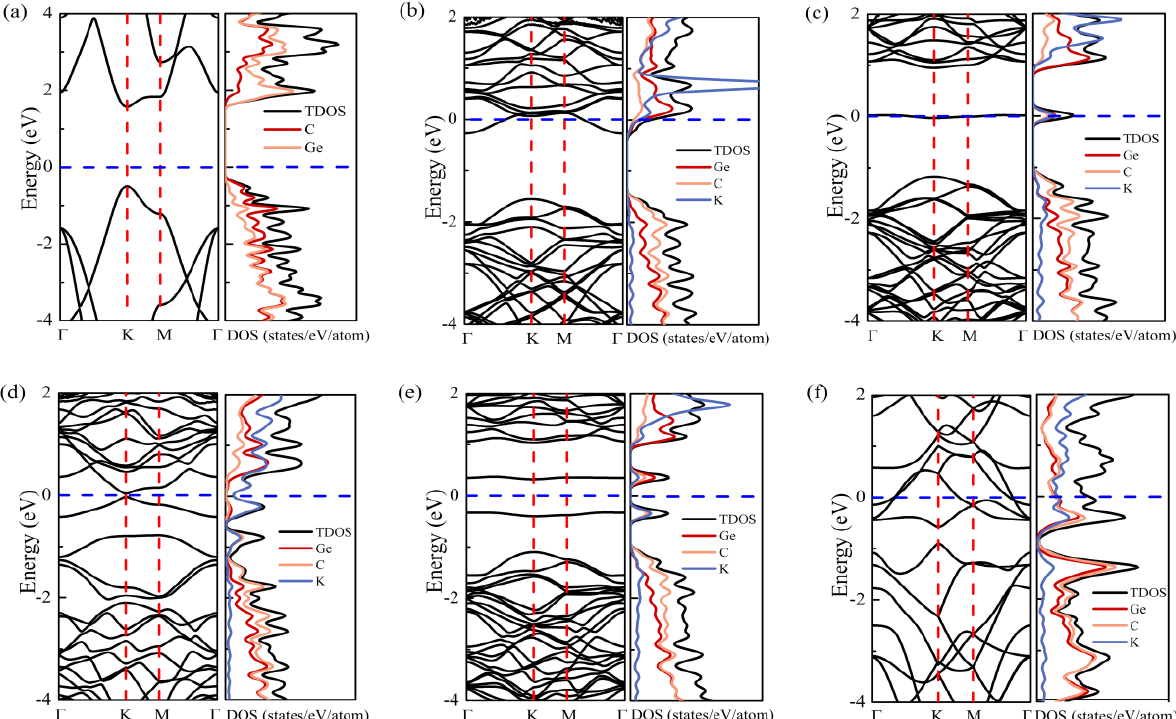
Figure 4. Band structure, density of states (DOS) and partial density of states (PDOS) of ( a ) pristine g-GeC, ( b , c ) g-GeC with K adsorption on H h and H ge sites at low concentration of x = 0.0626, ( d ) g-GeC with K concentration of x = 0.44, and ( e , f ) g-GeC with K adsorption by way of two-surface adsorption with K concentrations of x = 0.125 and x = 1.